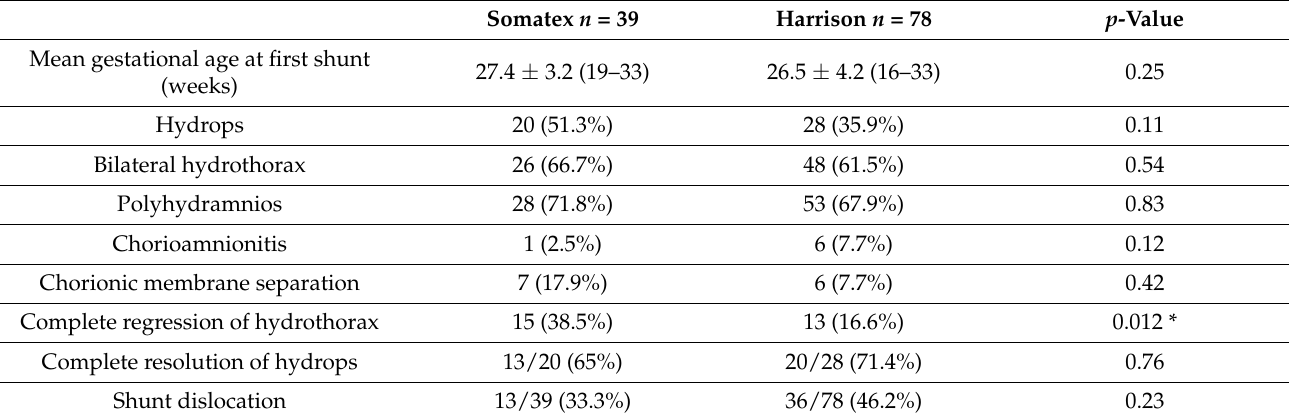
Table 2. Comparison of patient characteristics and outcome after TAS according to type of